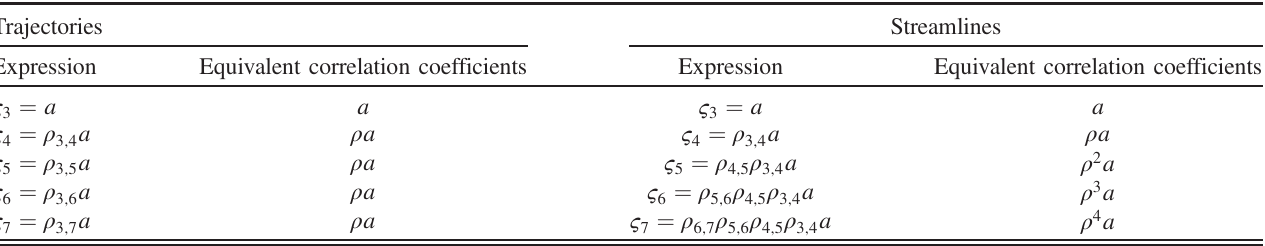
TABLE I. Anticipated theoretical sequences of scores for trajectories and streamlines with respect to the initial score. The full expression and the expression for equivalent correlation coefficients are given for several